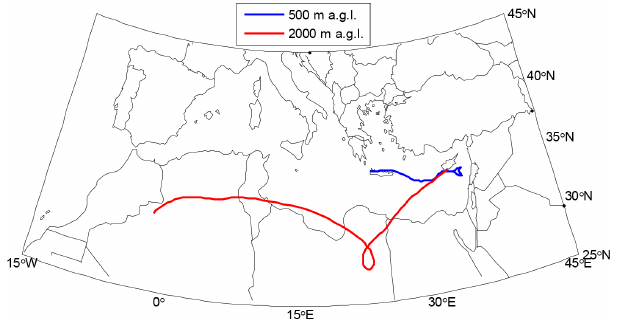
Figure 6. Back trajectories of 96h arriving at Limassol on 21 April 2017 at